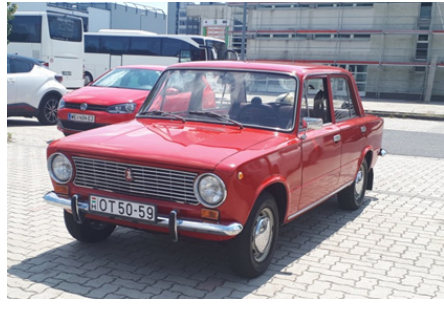
Figure 1. Lada 1200 The make (Lada 1200) refers to the displacement of the pistons which is 1200, more accurately 1198